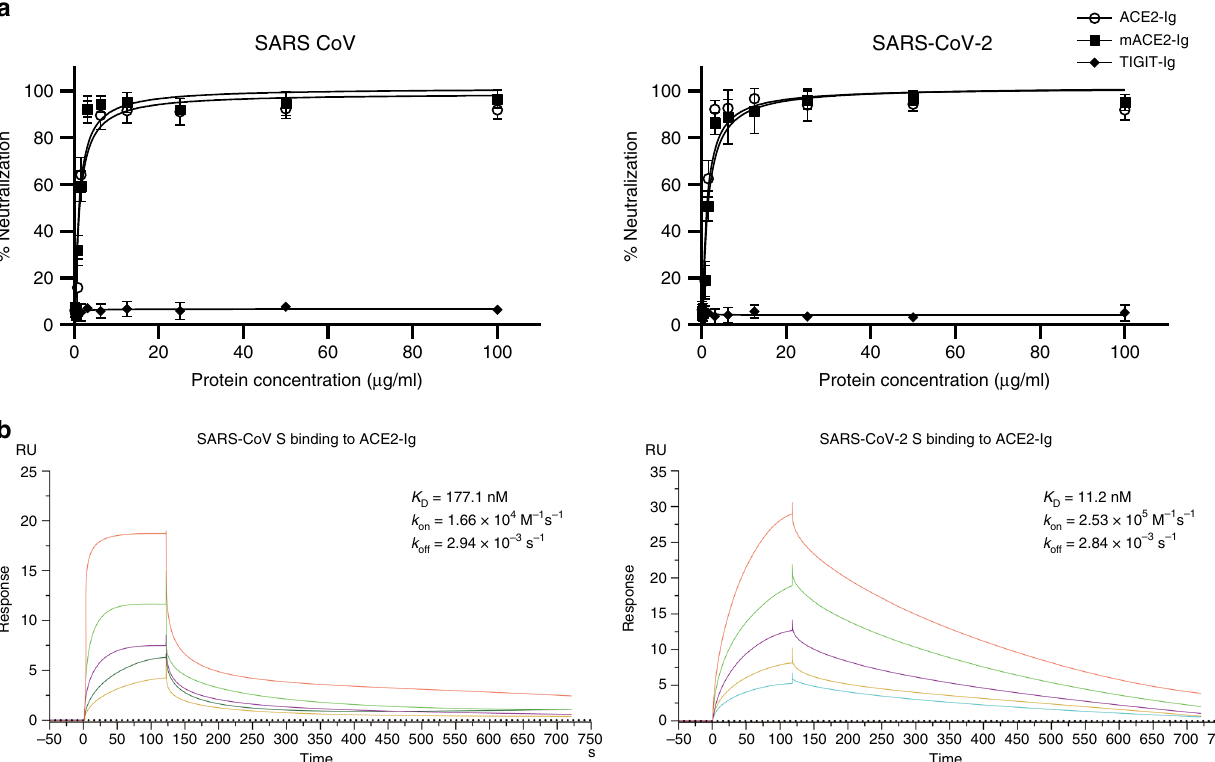
Fig. 3 Inhibition of cell fusion by ACE2-Ig. a Potent inhibition of cell fusion was mediated by the SARS-CoV (left) or SARS-CoV-2 (right) S glycoproteins. Cells expressing different S glycoproteins were incubated with the indicated fusion protein and mixed with ACE2-expressing cells. The activity of the reporter gene, β -gal, was measured as a correlate of fusion. The curves represent the best fi t to the experimental data, and were used to calculate IC 50 values. b Kinetic analysis of SARS-CoV S protein and SARS-CoV-2 S protein binding to ACE2-Ig was performed by surface plasmon resonance (SPR). Data are the means ± s.d. of four ( a ) independent biological replicates. Results shown represent three ( b ) independent experiments. Source data ( a ) are provided as a Source Data fi